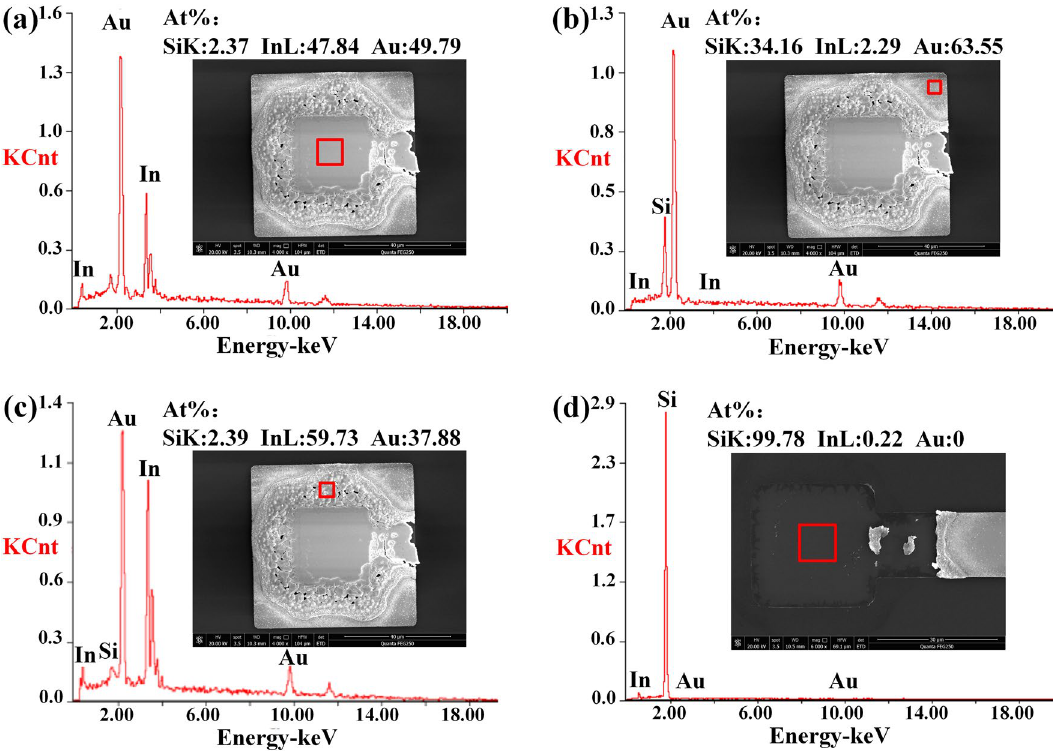
Figure 6. SEM/EDS image of fracture surface of bonded sample. Three different fracture positions were observed in ( a – c ), compared with the other fracture surface shown in ( d ), the fracture occurs at adhesive layer.